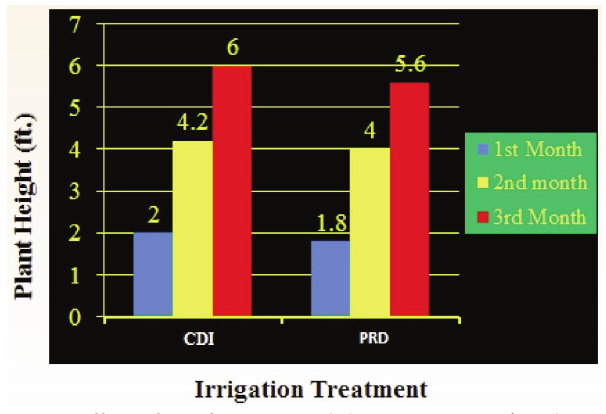
Fig. 2 - Effect of CDI (conventional dripping irrigation) and PRD (partial root-zone irrigation) on plant height over 3 months. Table 1 - Effect of PRD on tomato fruit size, total fresh weight, water content, fruit firmness, cluster/plant, fruit/cluster, shoot fresh weight, leaf area, and blossom-end rot